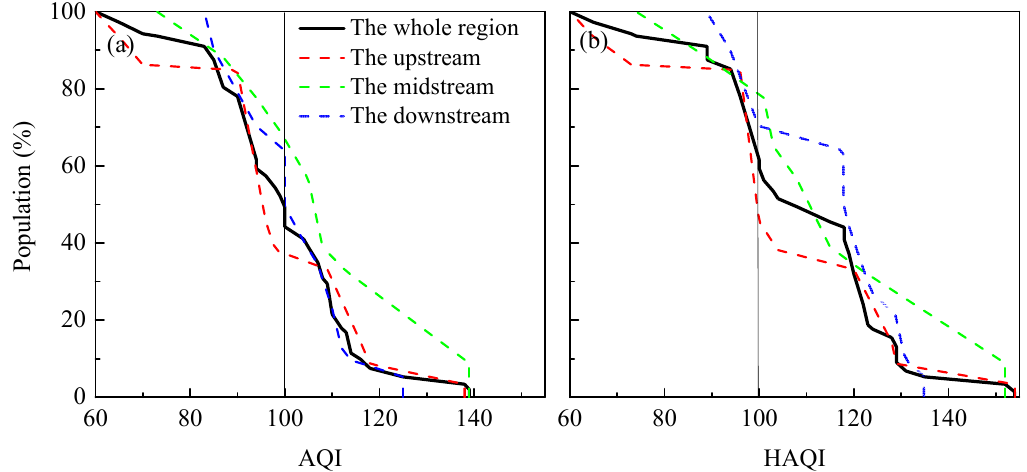
Figure 10. The cumulative population distribution (in % of the corresponding regions) based on the wintertime average ( a ) AQI and ( b ) HAQI.